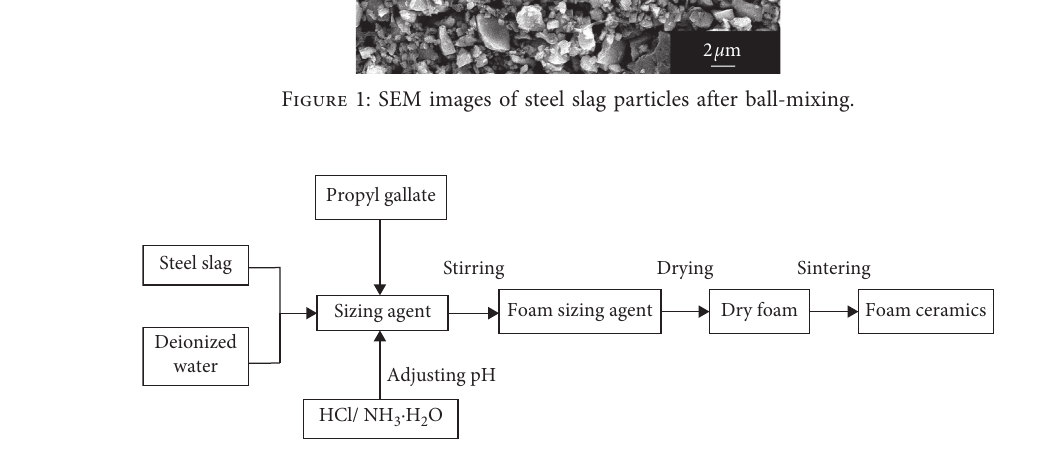
Figure 2: Preparation process of steel slag foam ceramics.